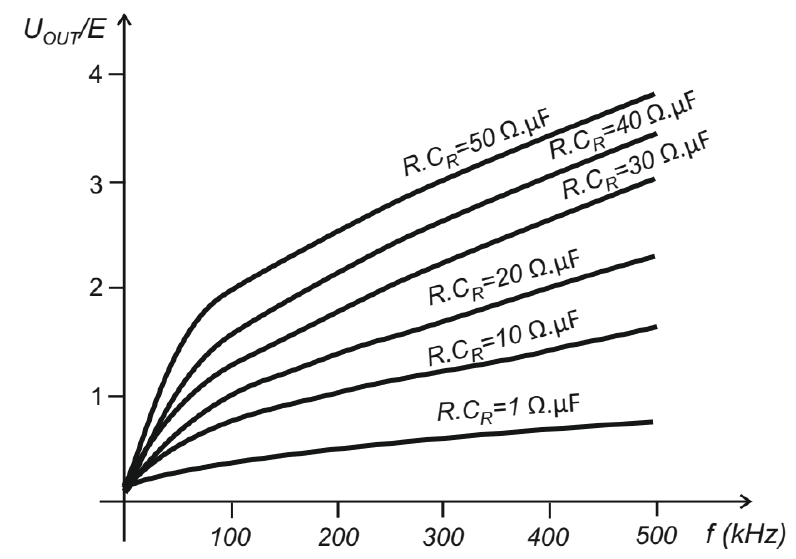
Figure 5. Control characteristics of a converter with energy dosing.